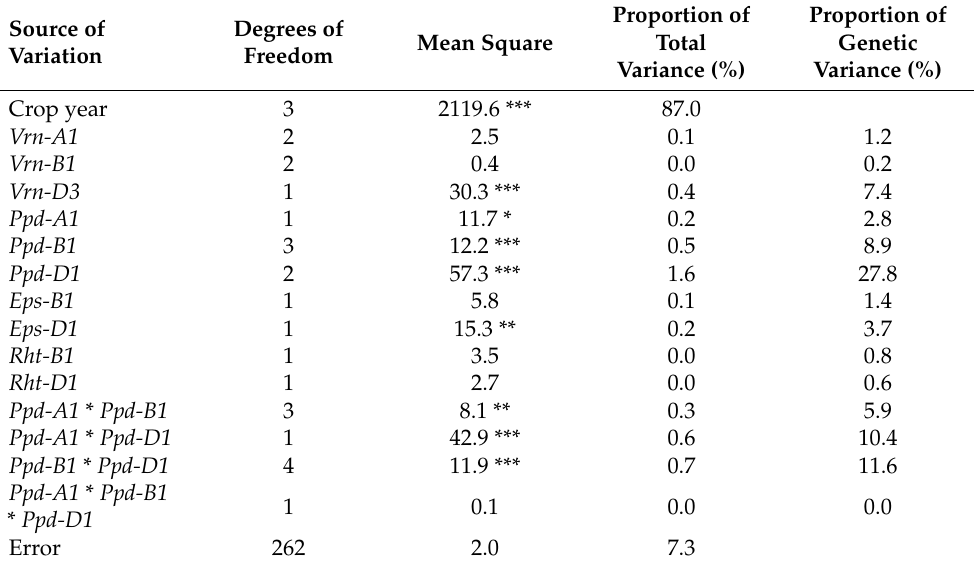
Table 3. The influence of crop year, and the vernalization ( Vrn ), photoperiod ( Ppd ), earliness per se ( Eps ) and reduced-height ( Rht ) genes and their interactions, on the heading date of eastern U.S. soft winter wheat genotypes in four crop